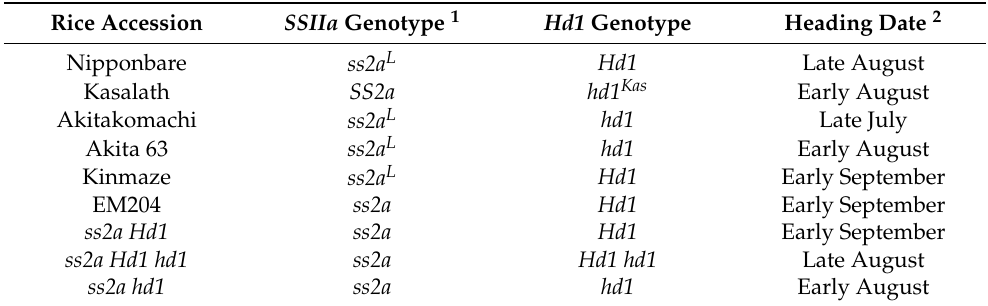
Table 1. Summary of the SSIIa and Hd1 genotypes and typical heading dates of rice accessions. Rice Accession